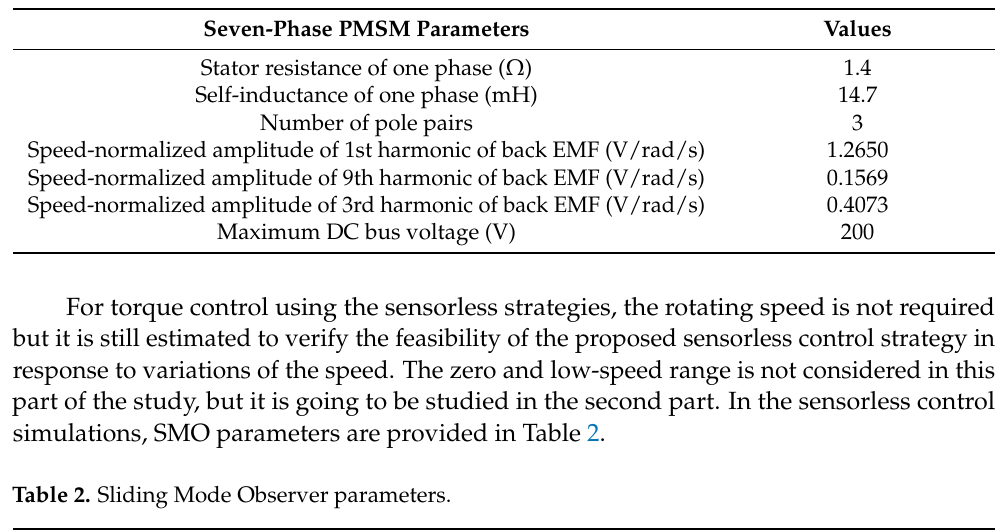
Table 1. Seven-phase PMSM characteristics.